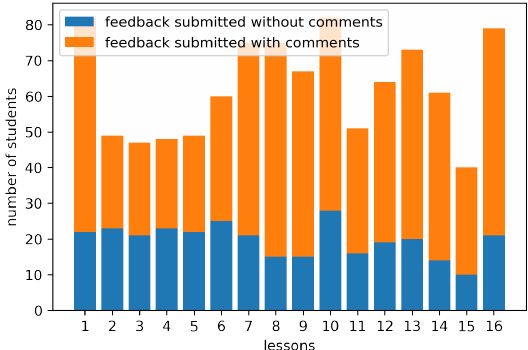
Figure 3. Statistics of the learning feedback